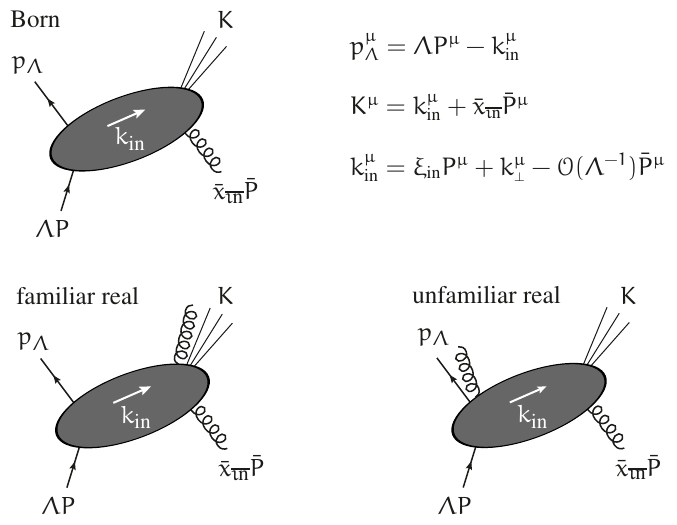
Figure 1 . Kinematics of the different contributions for the example in which the auxiliary partons are quarks, the collinear initial state parton is a gluon, and the real-radiation parton is also a